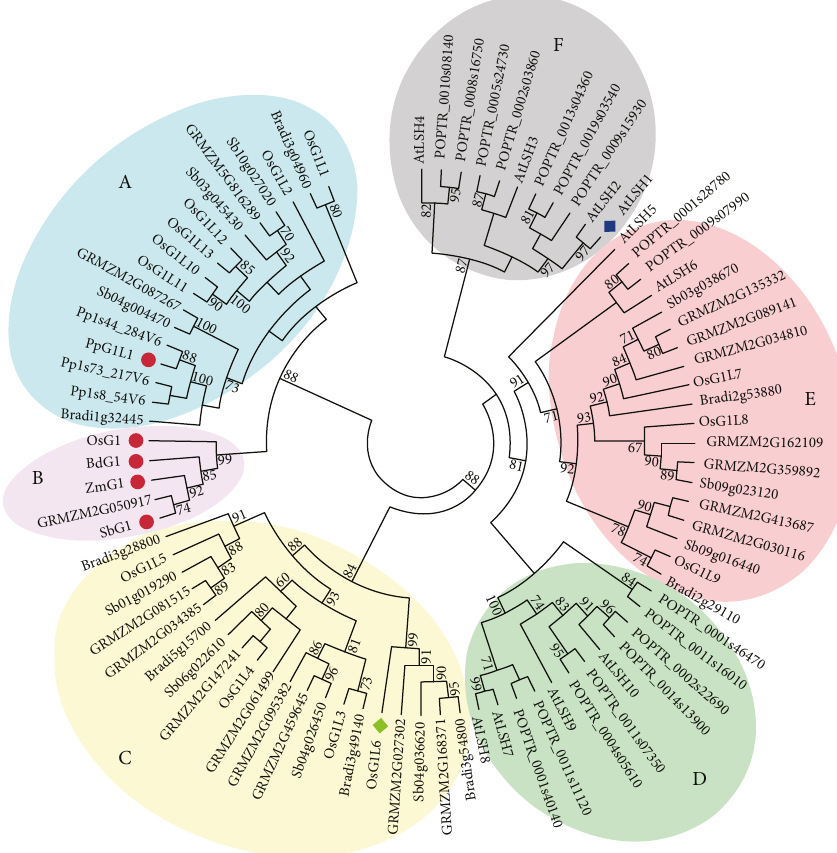
Figure 3: Phylogenetic relationships of the ALOG domain proteins in rice and six other species. Subgroups A to F are indicated in di ff erent colored